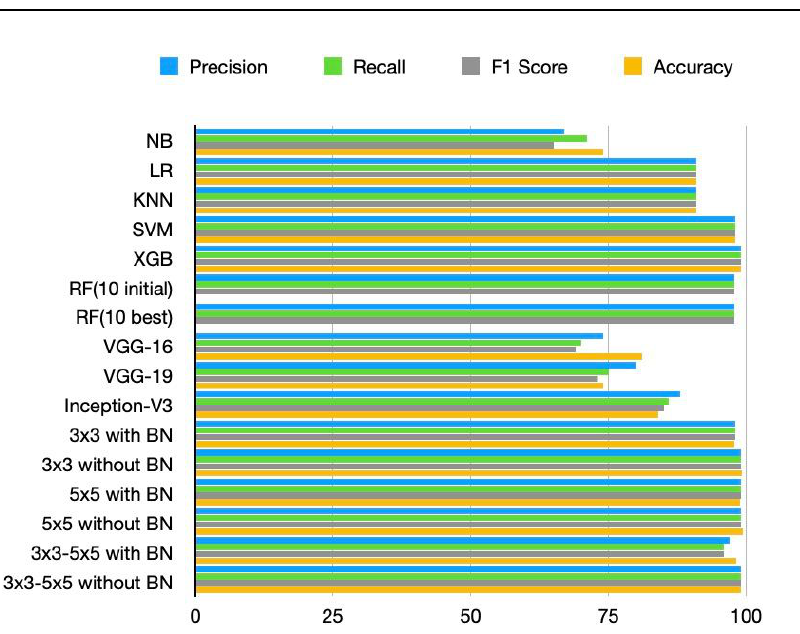
Figure 6. Comparison of models in terms of accuracy, precision, recall, and F1